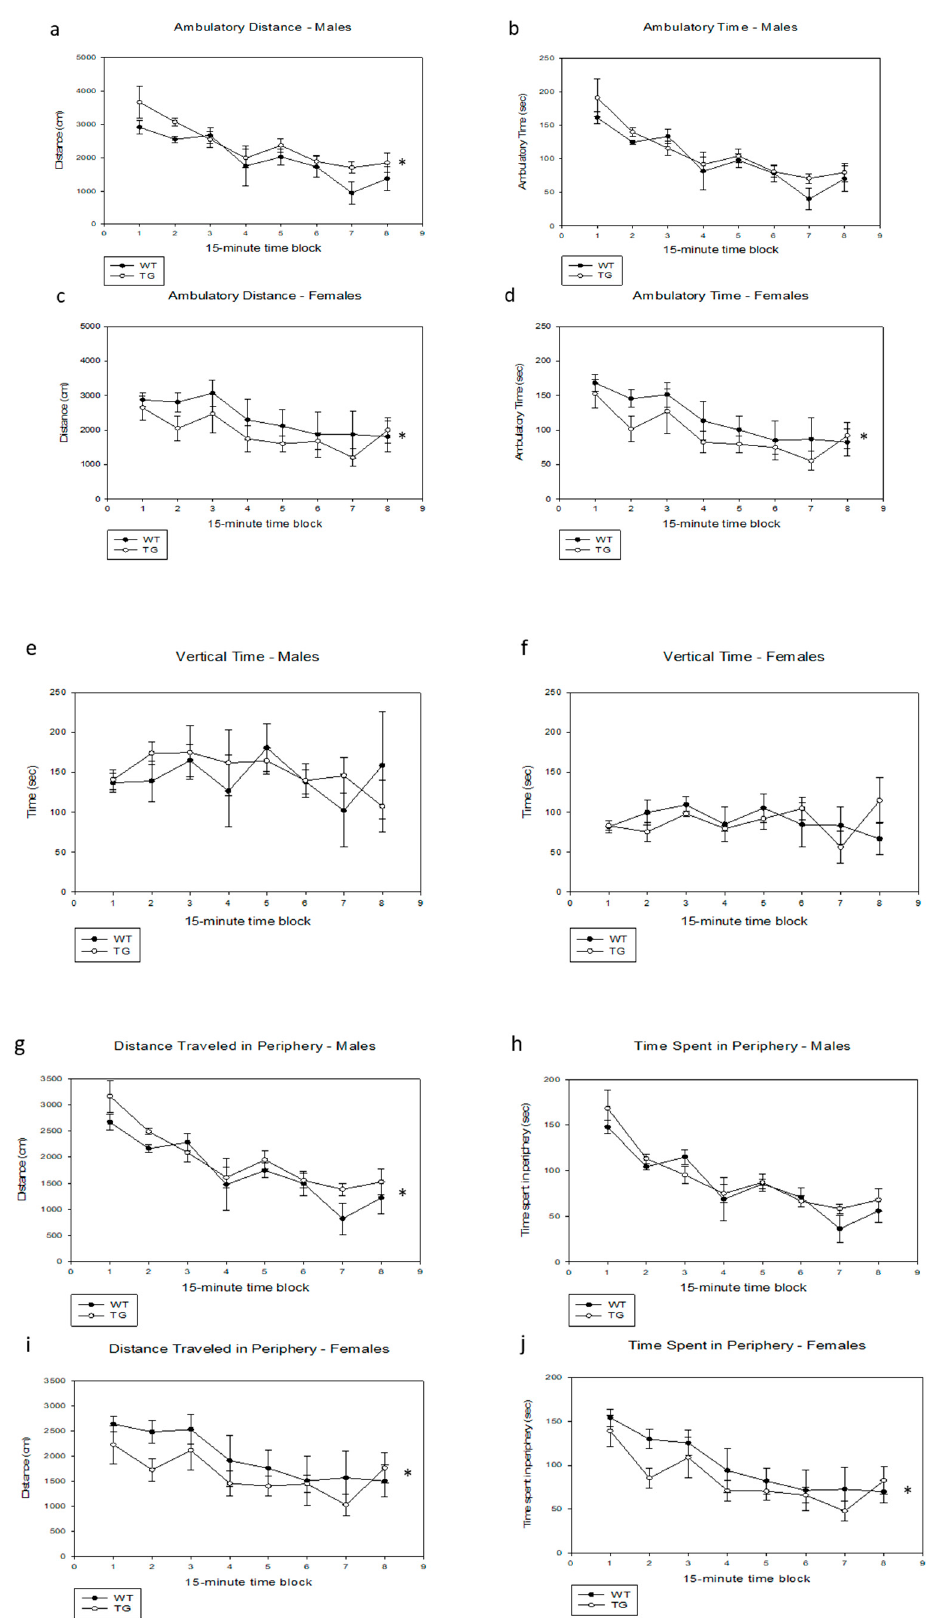
Figure 2. Activity of PDE4D5-D556A transgenic mice in an open field. Testing was performed for 2 h and activity analyzed for each 15-min block. Data are means ± SE; asterisks (*) indicate data from